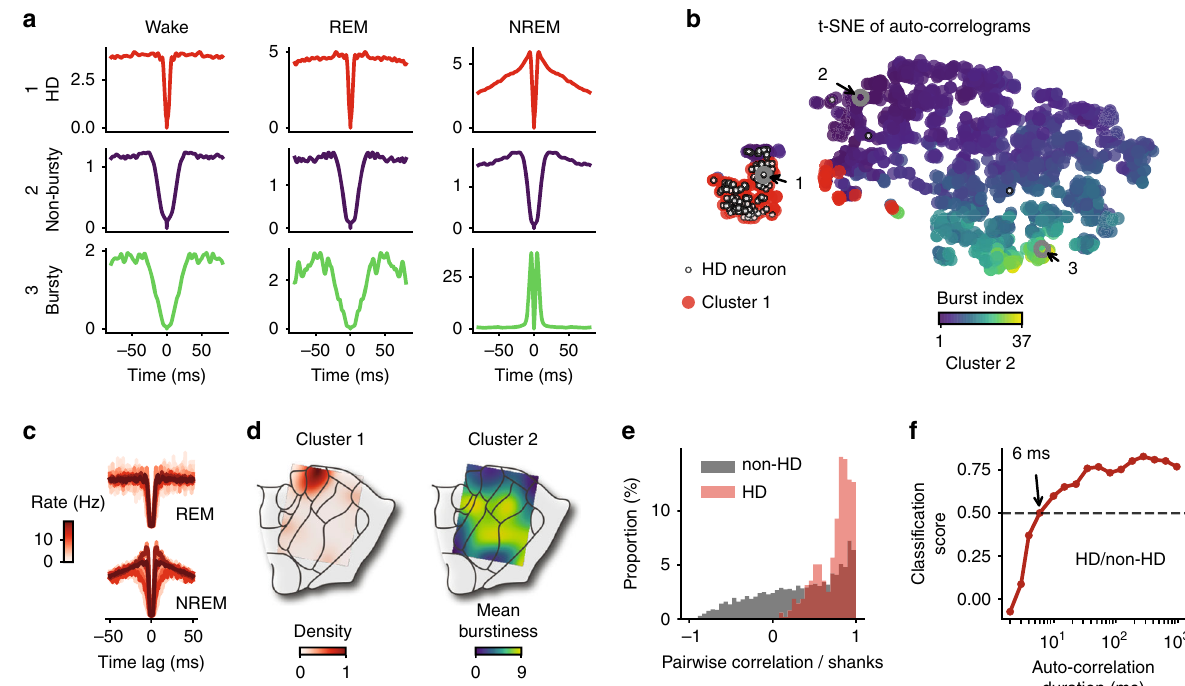
Fig. 5 Variability and clustering of spike auto-correlograms in the AT. a Auto-correlograms of an HD (1), non-bursty (2) and bursty (3) neuron during wake, REM sleep and NREM sleep epochs. b Clustering and t-SNE embedding of auto-correlograms (each point represents the stacked auto-correlograms from wake, REM sleep and NREM sleep of a neuron). HD neurons are marked with a white dot. The three example neurons from c are circled. K-means clustering of the auto-correlograms result in two clusters (see text). Cluster #2 is color-coded relative to burst index during NREM sleep. c Left, 15 superimposed auto-correlograms of randomly selected cells from cluster #1 (normalized by the baseline between 50 and 100 ms), during REM (top) and NREM (bottom) sleep. Color (white to dark red) indicates average fi ring rates (from low to high). Note the high similarity of auto-correlograms during REM sleep, independent of basal fi ring rates, and the mild variability during NREM sleep. d Left, density of cluster #1 (i.e. mostly HD neurons) and, right, mean burst index of cluster #2 over the anatomical schematics, for the same example mouse. e Distribution of Pearson ’ s correlation coef fi cients between pairs of neurons recorded on the same shank showing the dynamical homogeneity of HD neurons compared to non-HD neurons. f Classi fi cation score of HD versus non-HD neurons (based on auto-correlograms) for increasing duration of auto-correlation. Score is relative to classi fi ers trained with shuf fl ed data (0, chance level; 1, perfect classi fi cation).